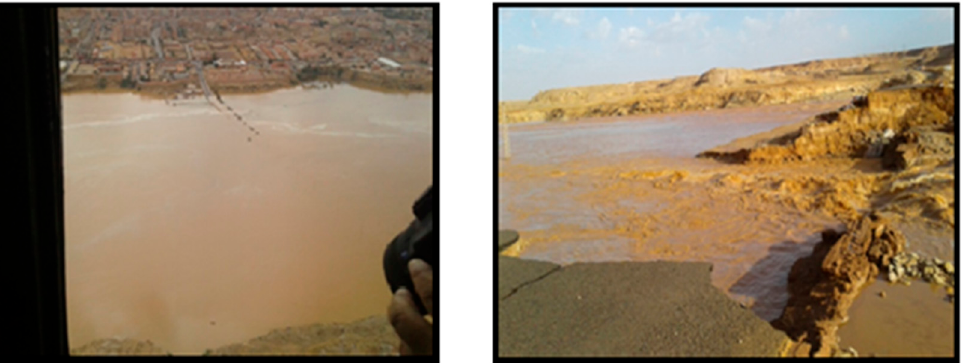
Figure 1. The national road N1 linking Laâyoune and Tarfaya submerged on the left, breach opening in the body of the dam embankment by the flash flood.